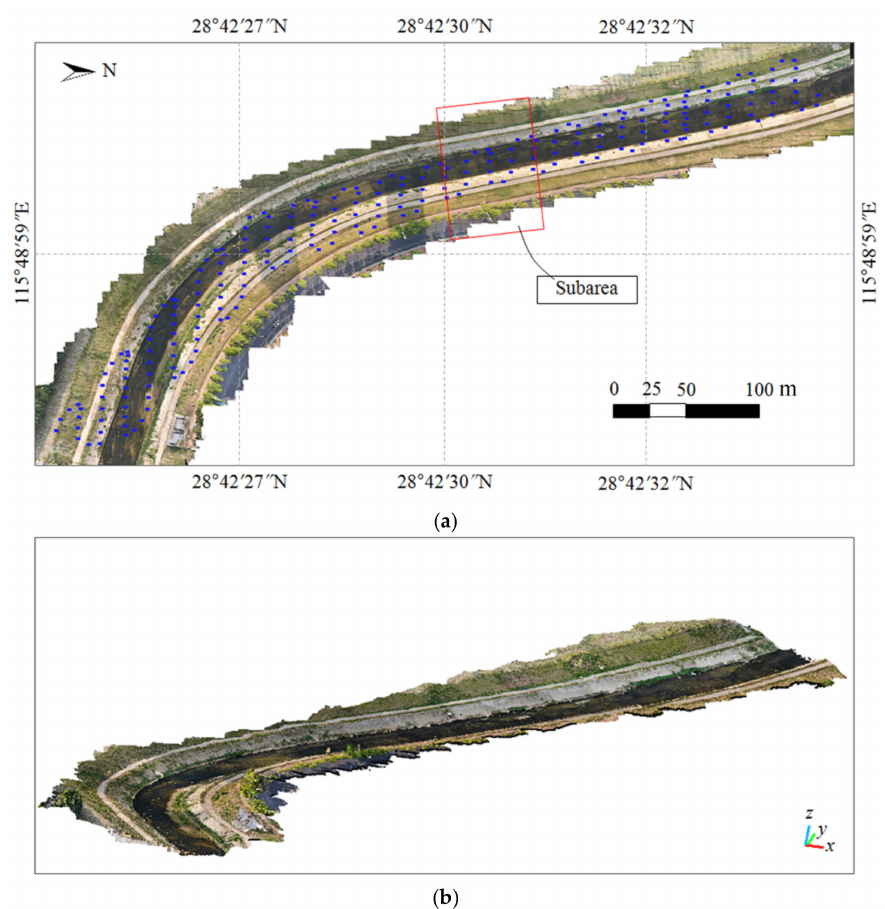
Figure 10. Dense point clouds derived from UAV photogrammetry. ( a ) Top view of the dense point clouds. ( b ) Oblique view of the dense point clouds. The viewpoints of the camera are marked by blue